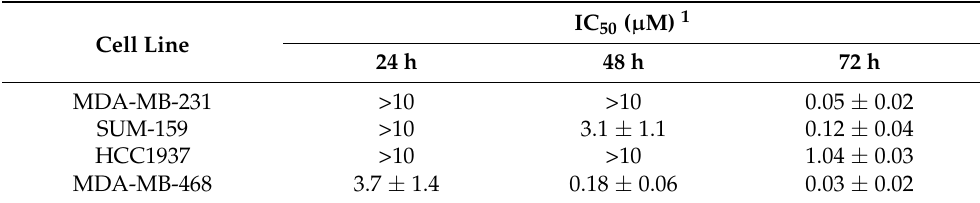
Figure 1. Effect of selinexor on cell growth and cell cycle distribution of TNBC cell lines. ( a ) MDA-MB-231, SUM-159, HCC1037, MDA-MB-468 cells and human normal breast cells (MCF-10A) were cultured for different time intervals in the presence of increasing concentrations of selinexor or 0.1 % ( v / v ) DMSO (control cells; ctr), and the cytotoxic activity was assessed by MTS assay. Data are expressed as the percentage of cells (mean values ± SD of three independent experiments) in each conditions with respect to control cells (ctr). ( b ) Flow cytometric analysis of cell cycle distribution in TNBC cells exposed to 0.1 % ( v / v ) DMSO (control cells; ctr) and selinexor (IC 50 at 72 h, as reported in Table 1). Data are reported as the percentage of cells in G1, S, and G2/M phases and represent the mean values of three independent experiments; SDs were always within 5%. Only G1 phase comparisons were explicited. * p < 0.05, *** p < 0.005 Tukey’s post hoc test. Table 1. Cell growth inhibitory activity of selinexor in TNBC cell